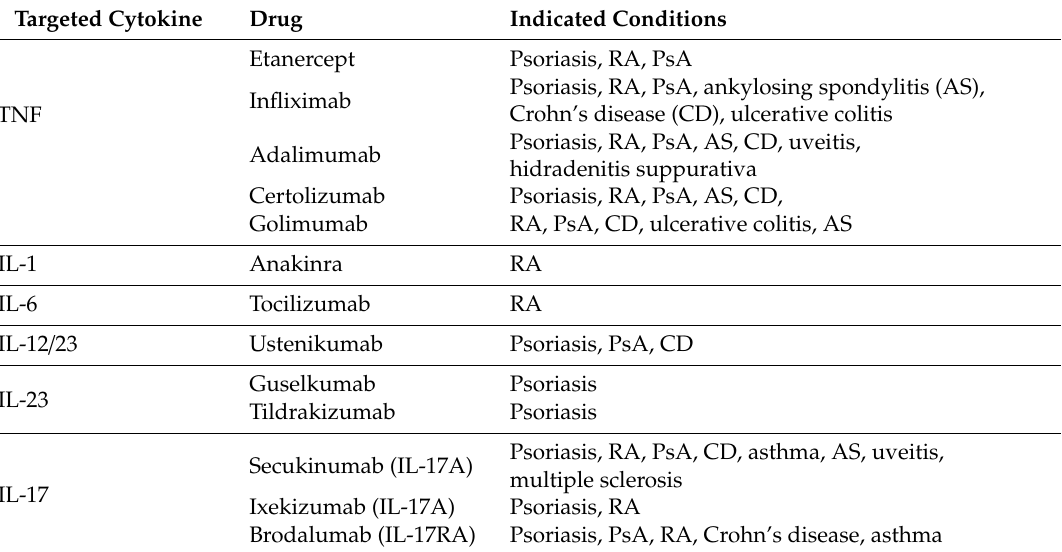
Table 1. Target cytokines involved in IL-17 pathways and approved inhibitors in the management of immune-mediated inflammatory diseases. Targeted